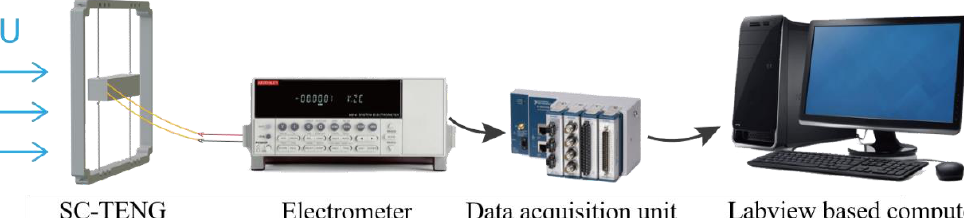
Figure A2. Experimental apparatus of the vibration characteristics of the SC-TENG.